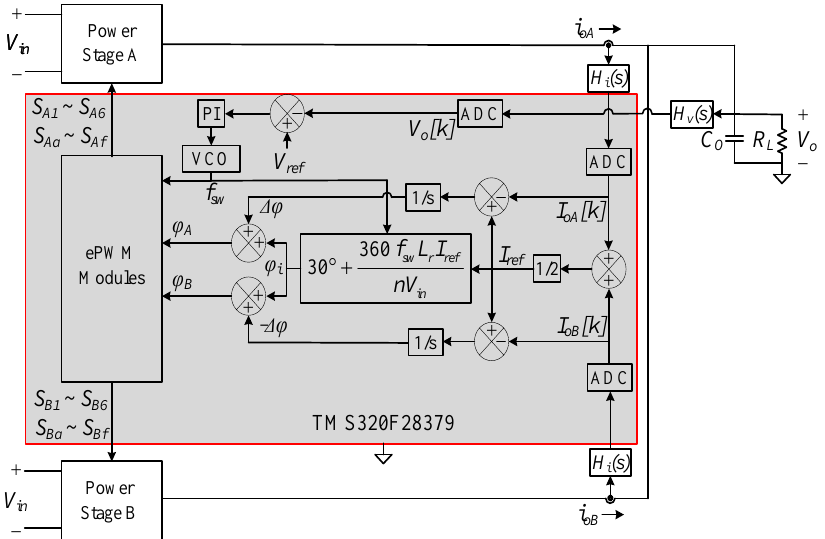
Figure 9. Digital control block diagram. ( i oA : output current of ModuleA; i oB : output current of ModuleB; H v (s) ; H i (s) ; ADC: analog to digital converter; k : sampled digital control cycle; V o [k] : digital value of V o ; I oA [k] : digital value of i oA ; I oB [k] : digital value of i oB ; I ref : reference current; PI: proportional-integral controller; V CO : voltage-control oscillator; S A 1 ~ S A 6, S A a ~ S A f, S B 1 ~ S B 6, S Ba ~ S Bf : MOSFET signals).